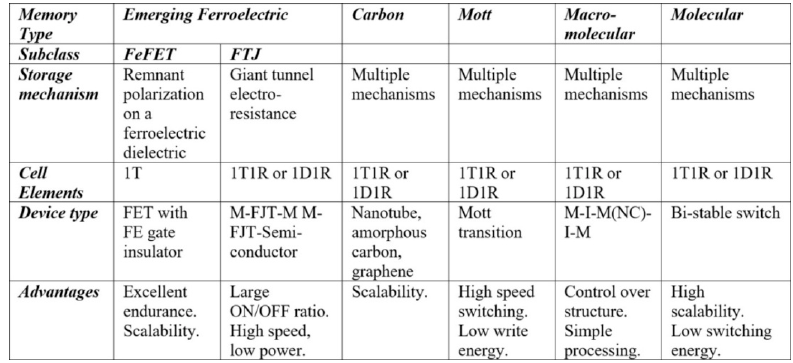
Figure 4. Advantages of di ff erent emerging nonvolatile memory (NVM) technologies [3].